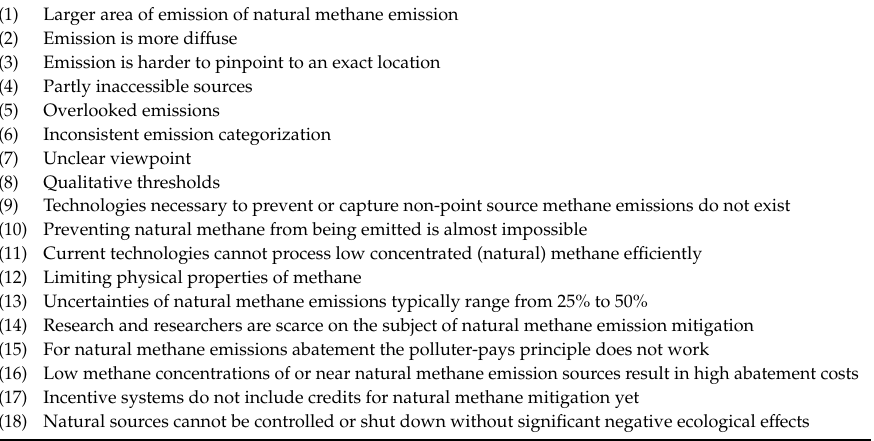
Table 3. Summary of the identified